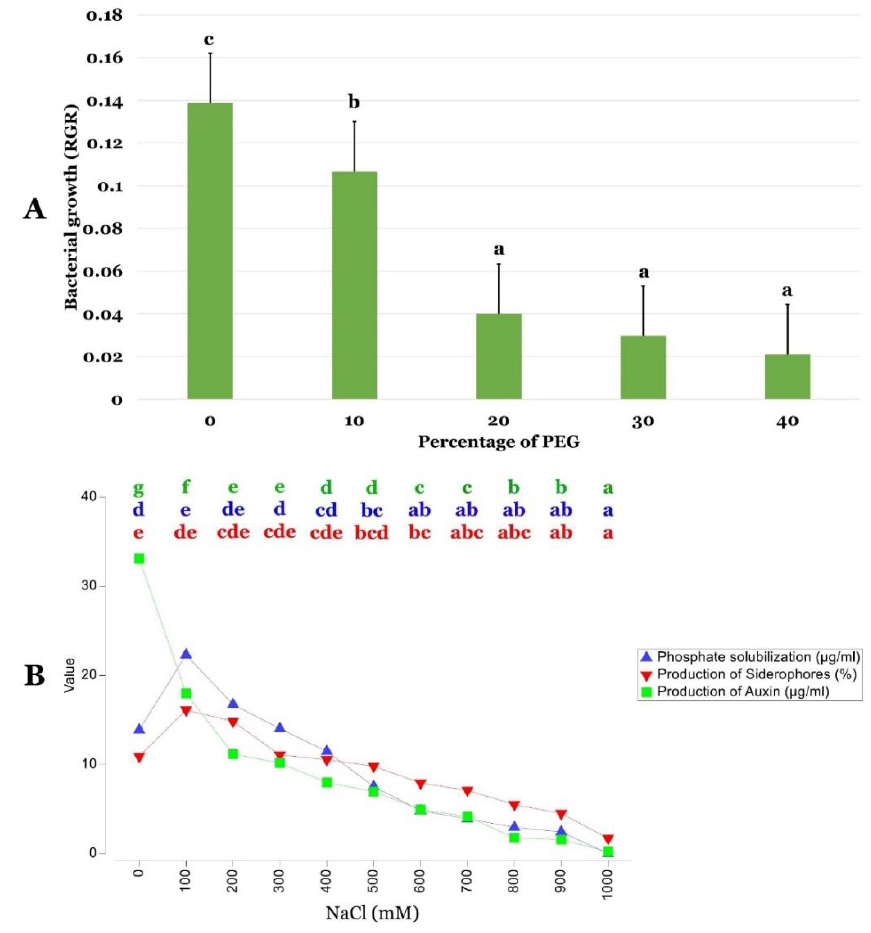
Figure 2. Growth performance of P. agglomerans strain Pa to polyethylene glycol (PEG) stress and its plant growth promoting (PGP) abilities and stabilities toward salt stress. ( A ) Effect of PEG percentage on bacterial growth (RGR). ( B ) Coherence chart illustrating the stability of PGP abilities of P. agglomerans strain Pa to varying NaCl concentrations. Data are represented by the mean of three repetitions ± standard error. One-way ANOVA was performed by using SPSS 22 and subsequent Tukey’s multiple comparison post-test. Points that are labeled with di ff erent letters indicate significantly di ff erent values ( p < 0.05) among the treatments.